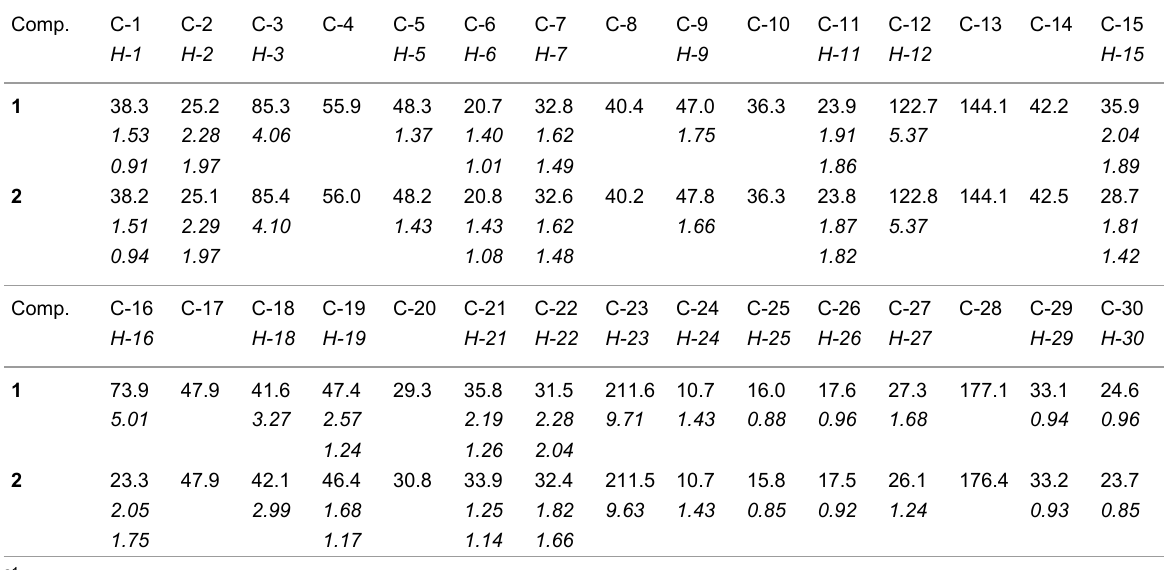
Table 1: 1 H and 13 С NMR data ( δ , ppm) of the triterpene units of compounds 1 and 2 (500 MHz, pyridine- d 5 /D 2 O 1:1). a